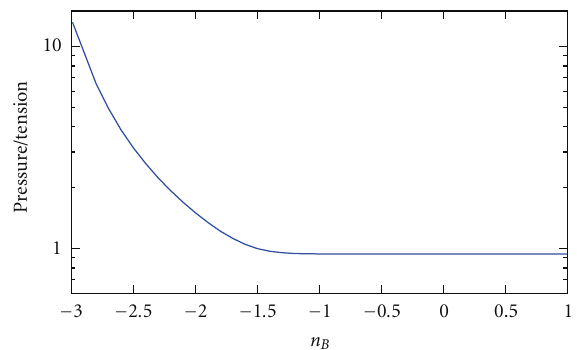
Figure 2: Ratio of stocahstic PMF pressure and tension sources. For illustration, the cuto ff scale k C was fixed to k C = 10Mpc − 1 . The pressure dominates for n B < − 1 . 5, and the magnetic tension dominates for n B > − 1 .